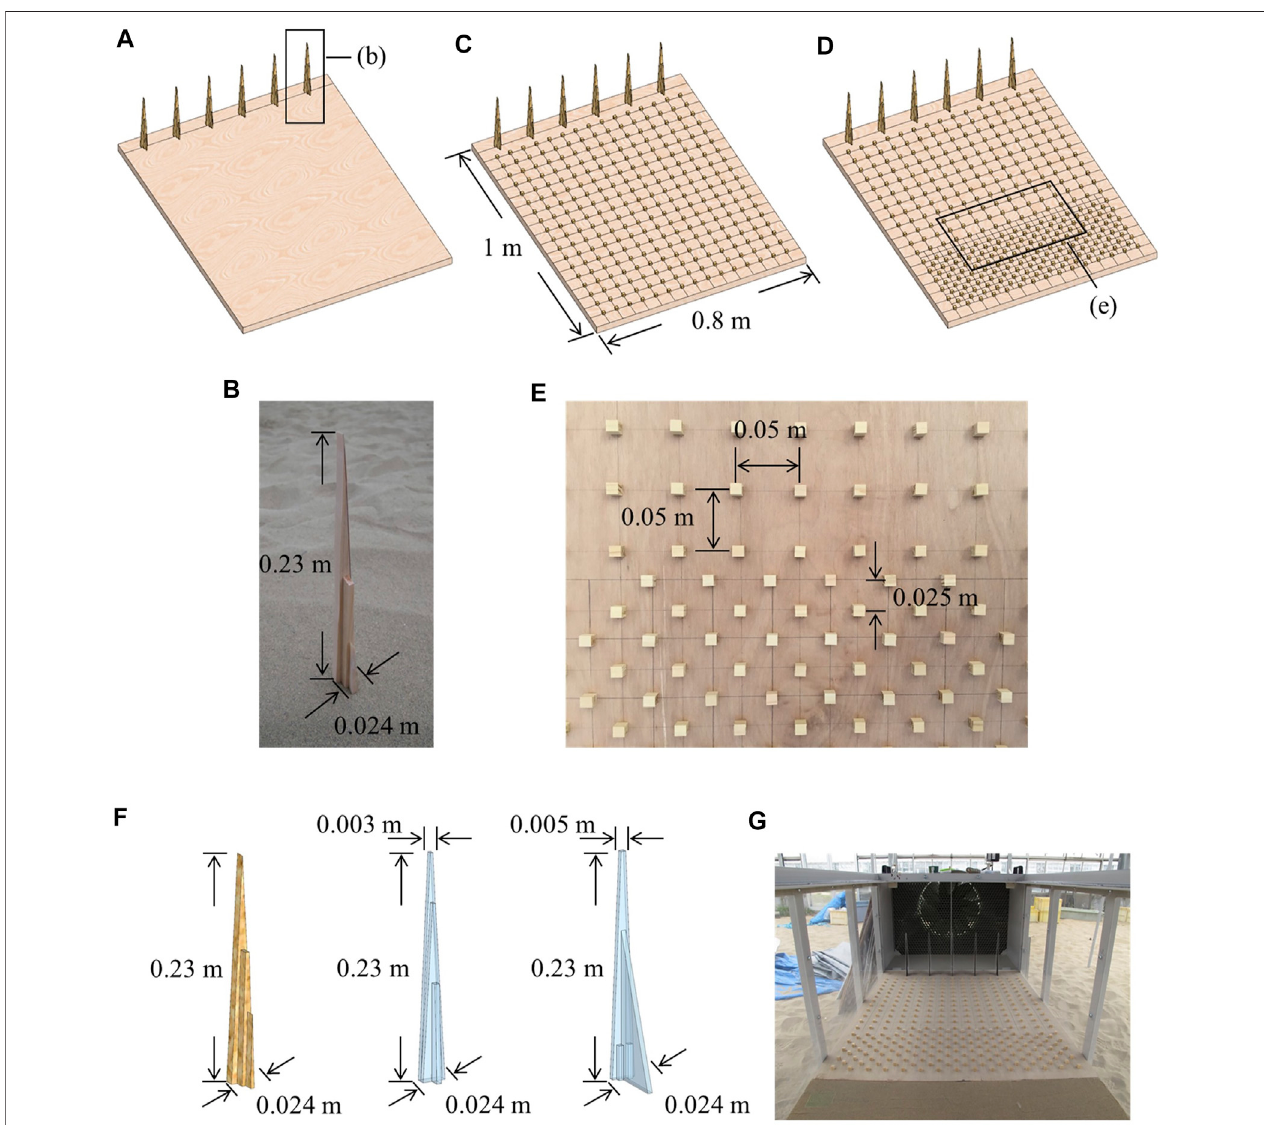
FIGURE 2 | Installations of (A) spires based on the original design [see panel (B) ] and (C) roughness blocks with adjustment of their spatial density [see panel (D, E) ]. (F) Modi fi cation of the width of upper base of spires. (G) Photography showing the con fi guration of the turbulence generator.